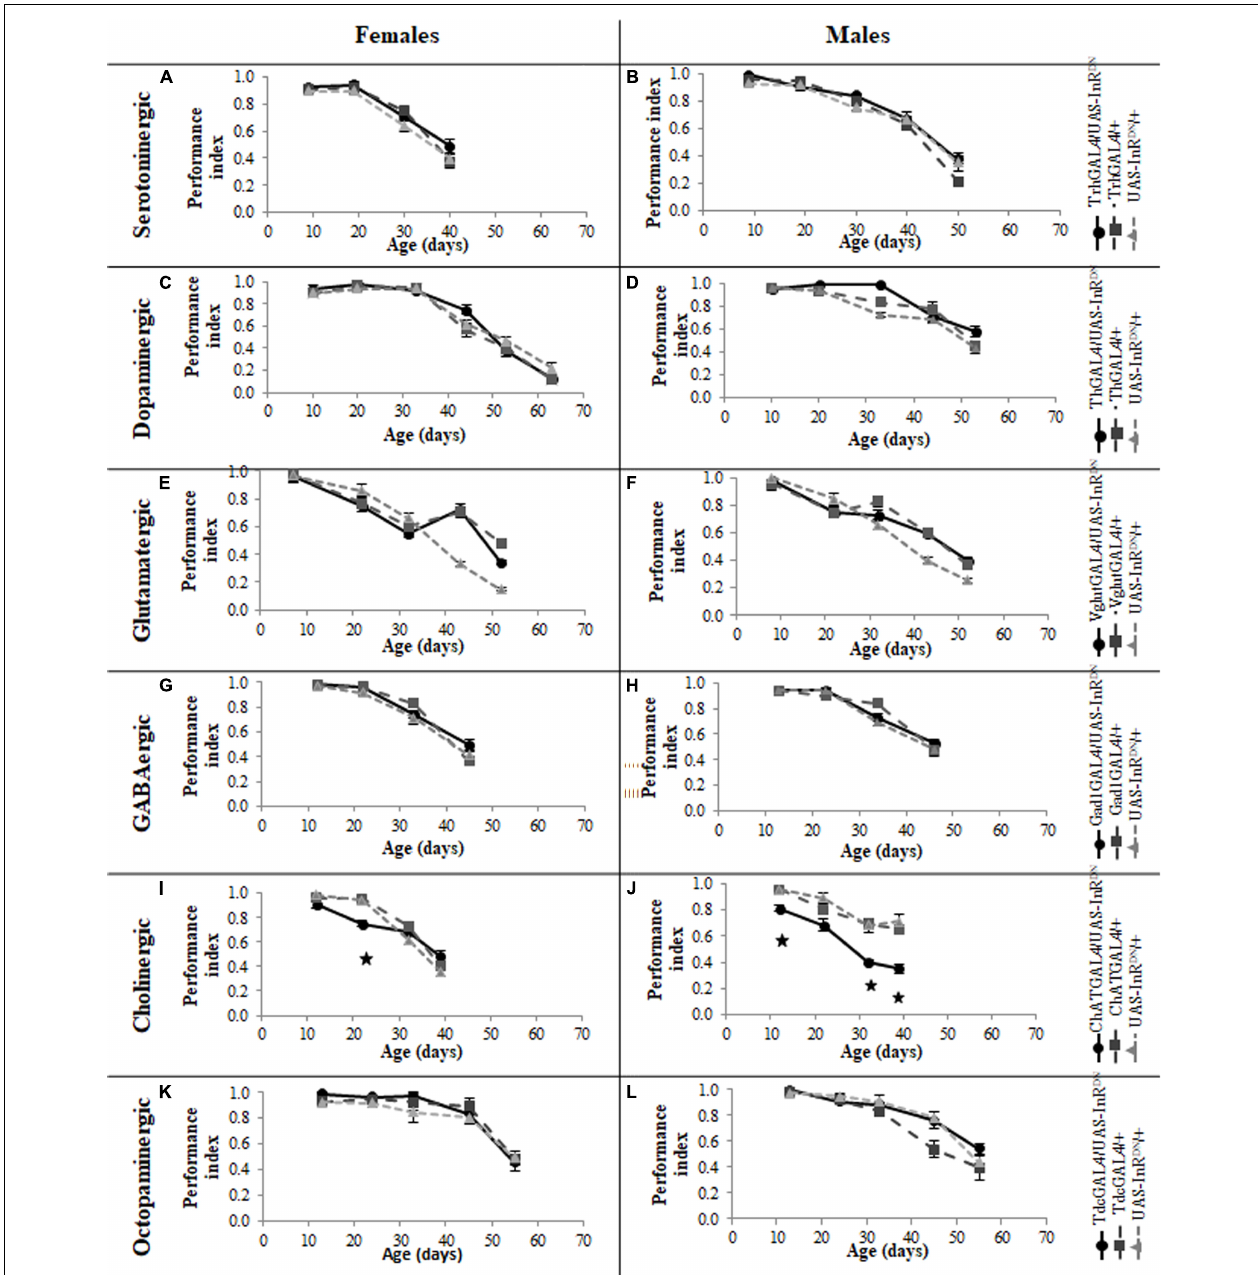
FIGURE 2 | Effect of constitutive IIS reduction in specific neuronal subtypes on negative geotaxis senescence. (A) Negative geotaxis performance index over the lifespan of TrhGAL4/UAS-InR DN once mated female flies compared to TrhGAL4/ + and UAS-InR DN / + controls, N = 3 (groups of 10 flies) for each genotype. (B) Negative geotaxis performance index over the lifespan of TrhGAL4/UAS-InR DN male flies compared to TrhGAL4/ + and UAS-InR DN / + controls, N = 3 (groups of 10 flies) for each genotype. (C) Negative geotaxis performance index over the lifespan of ThGAL4/UAS-InR DN once mated female flies compared to ThGAL4/ + and UAS-InR DN / + controls, N = 3 (groups of 10 flies) for each genotype. (D) Negative geotaxis performance index over the lifespan of ThGAL4/UAS-InR DN male flies compared to ThGAL4/ + and UAS-InR DN / + controls, N = 3 (groups of 10 flies) for each genotype. (E) Negative geotaxis performance index over the lifespan of VglutGAL4/UAS-InR DN once mated female flies compared to VglutGAL4/ + and UAS-InR DN / + controls, N = 3 (groups of 10 flies) for each genotype. (F) Negative geotaxis performance index over the lifespan of VglutGAL4/UAS-InR DN male flies compared to VglutGAL4/ + and UAS-InR DN / + controls, N = 3 (groups of 10 flies) for each genotype. (G) Negative geotaxis performance index over the lifespan of GAD1GAL4/UAS-InR DN once mated female flies compared to GAD1GAL4/ + and UAS-InR DN / + controls, N = 3 (groups of 10 flies) for each genotype. (H) Negative geotaxis performance index over the lifespan of GAD1GAL4/UAS-InR DN male flies compared to GAD1GAL4/ + and UAS-InR DN / + controls, N = 3 (groups of 10 flies) for each genotype. (I) Negative geotaxis performance index over the lifespan of ChATGAL4/UAS-InR DN once mated female flies compared to ChATGAL4/ + and UAS-InR DN / + controls, N = 3 (groups of 10 flies) for each genotype. At the age of 22 days ChATGAL4/UAS-InR DN showed decreased negative geotaxis response compared to the controls ( P = 0.0001 to ChATGAL4/ + and P = 0.0003 to